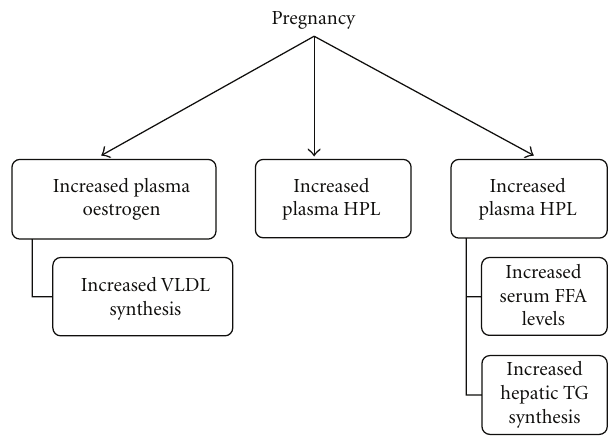
Figure 2: Schematic representation of HTG-related hormonal changes during pregnancy.